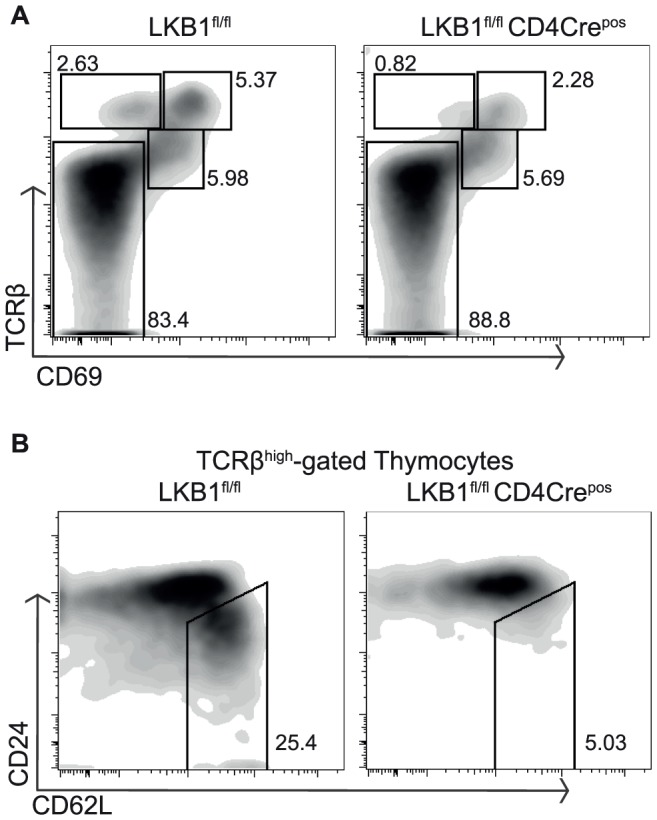
LKB1 is required for the progression of positive selection and maturation of T cells.(A) Thymi from LKB1fl/fl CD4Creneg and CD4Crepos mice were analysed for the co-expression of TCRβ and CD69 using flow cytometry as previously described [6], [7], [13]. (B) Flow cytometric analysis of TCRβhigh cells stained for the surface expression of CD24 (heat stable antigen) and CD62L (L-selectin). Data shown are representative of at least three mice.